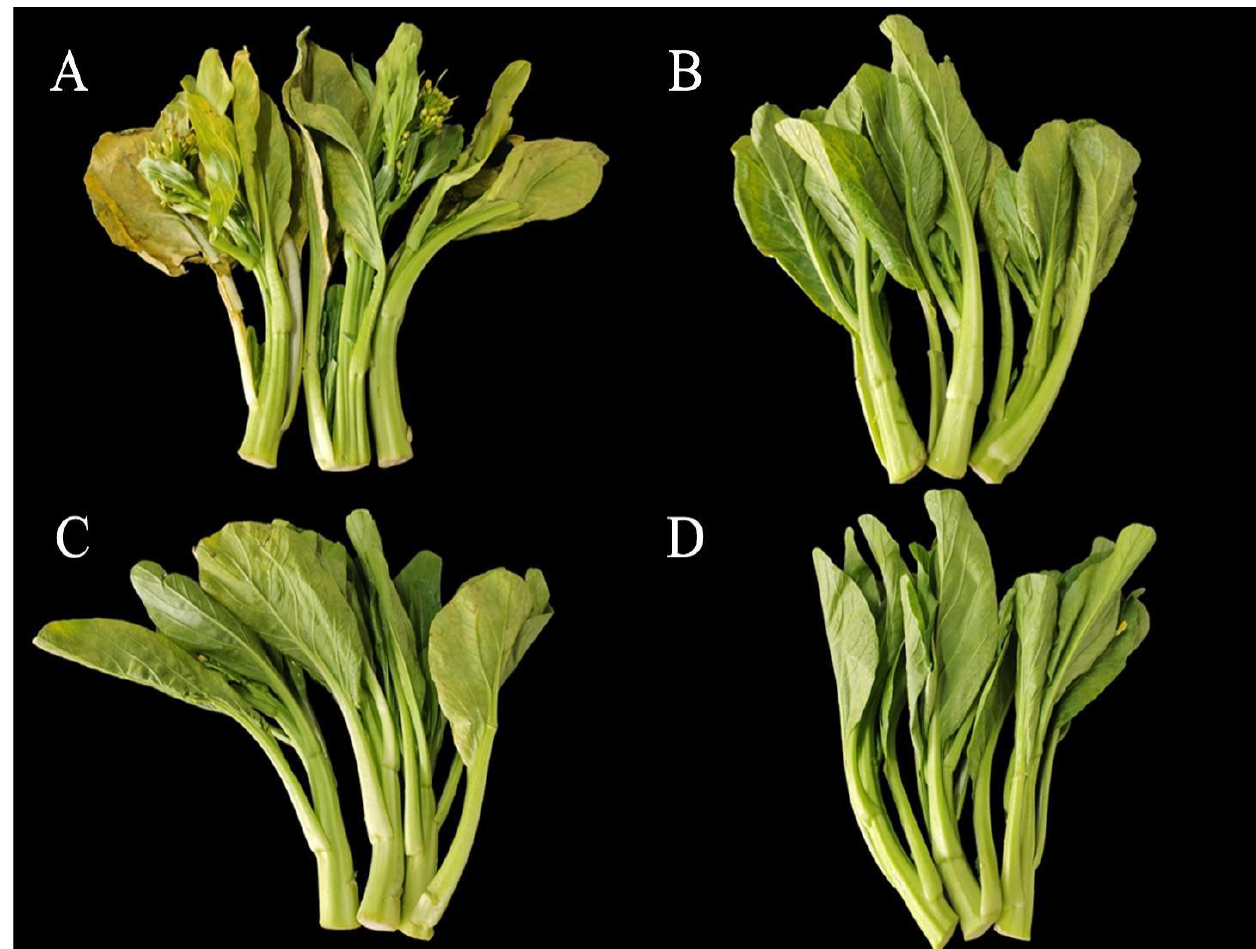
Figure 1. The phenotype of postharvest flowering Chinese cabbage treated with benzoic acid, chlorine dioxide, and 1-MCP was stored at 4 ℃ for 20 days. ( A ) control group, ( B ) chlorine dioxide treated group, ( C ) benzoic acid treated group, and ( D ) 1-MCP treated group.